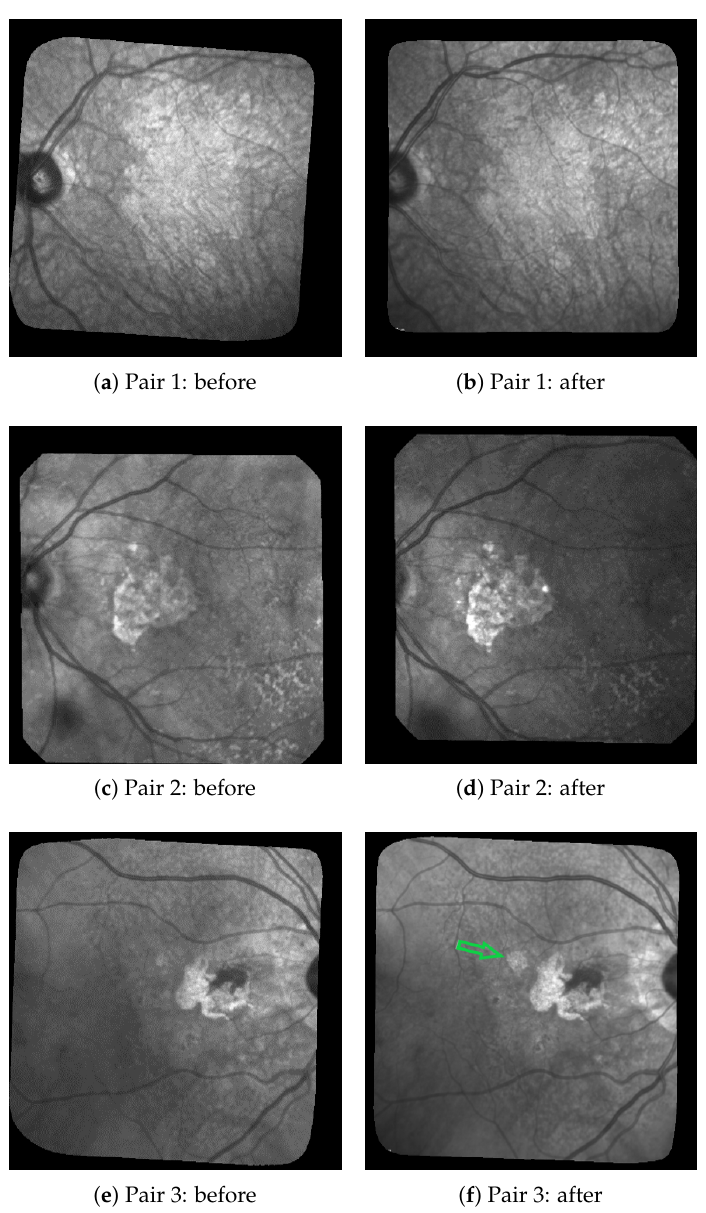
Figure 1. 3 of pairs of images acquired six months apart, the GA corresponds to the bright areas. The green arrow in ( f ) shows a new